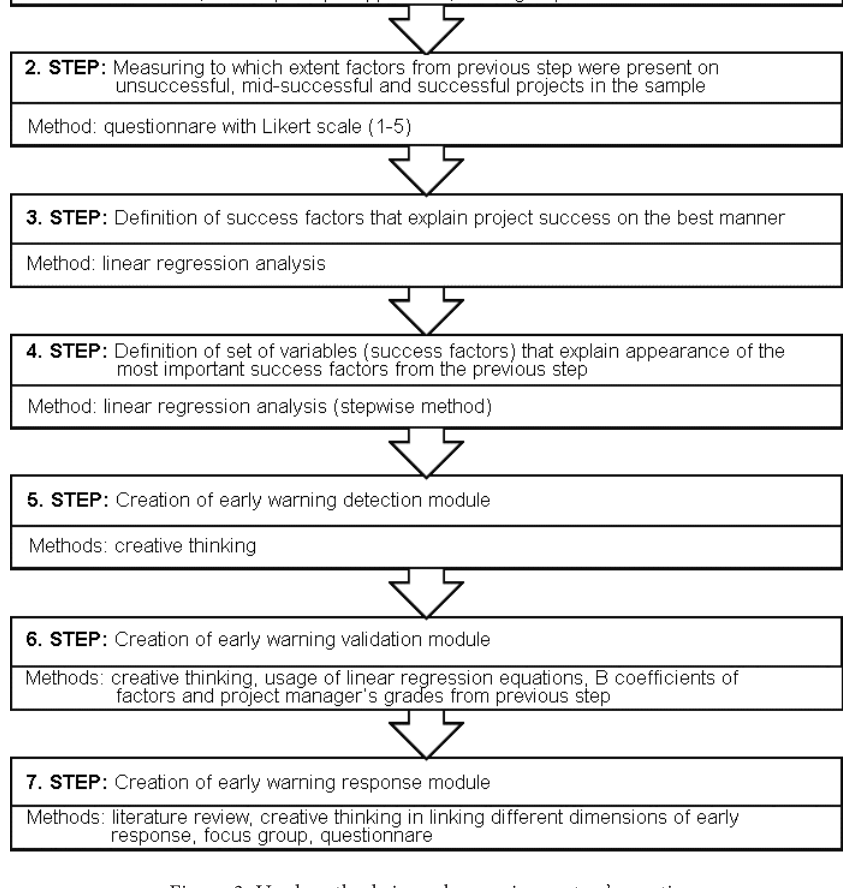
Figure 3. Used methods in early warning system’s